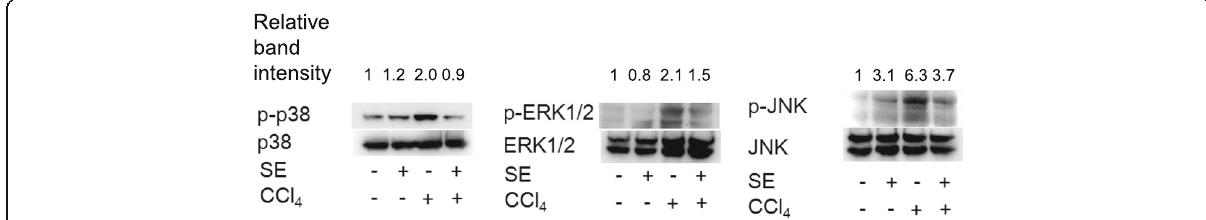
Fig. 8 Effect of SE on phosphorylation of JNK, p38, and ERK1/2 in the liver. Animals treated as described in Fig. 2 were euthanized at 72 h post intraperitoneal injection, and the liver tissues were isolated. Proteins were isolated and western blotting was performed. The data indicated increased hepatic phosphorylation of JNK, p38, and ERK1/2, demonstrating ERK1/2 activation of each MAPK. Total JNK, p38, and ERK1/2 levels were measured as internal controls. Band intensity was measured using ImageJ